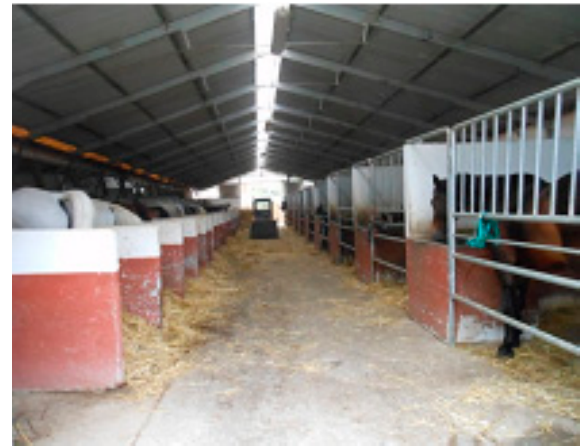
Figure 2. Horse stable where the horses were led and fed before the training.